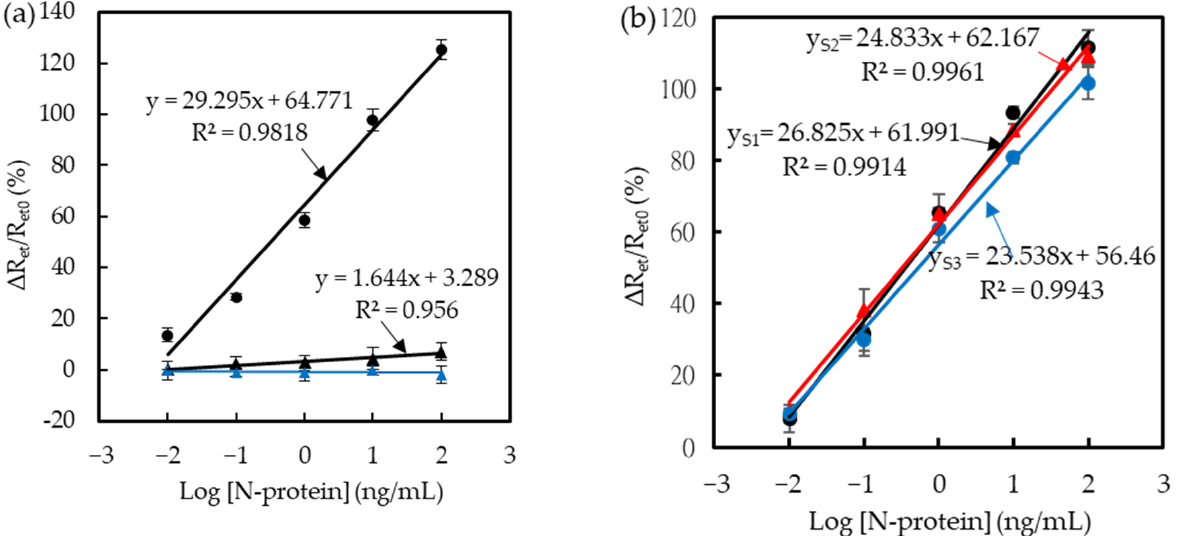
Figure 4. Effect of saliva on the sensing properties of BioAb/SA-BSA/MPA/SPCE-based immunosen- sors. Each curve was obtained from three individual immunosensors. ( a ) The black circle, the black triangle, and the blue triangle indicate the EIS measurements in SARS-CoV-2-spiked saliva, diluted saliva, and blank PBS, respectively. ( b ) The ∆ R et /R et0 response measured from three individual sensors in the N-protein-spiked volunteer salivary samples. Black, red, and blue lines indicate the regression curves of the S1, S2, and S3 sensors, respectively.